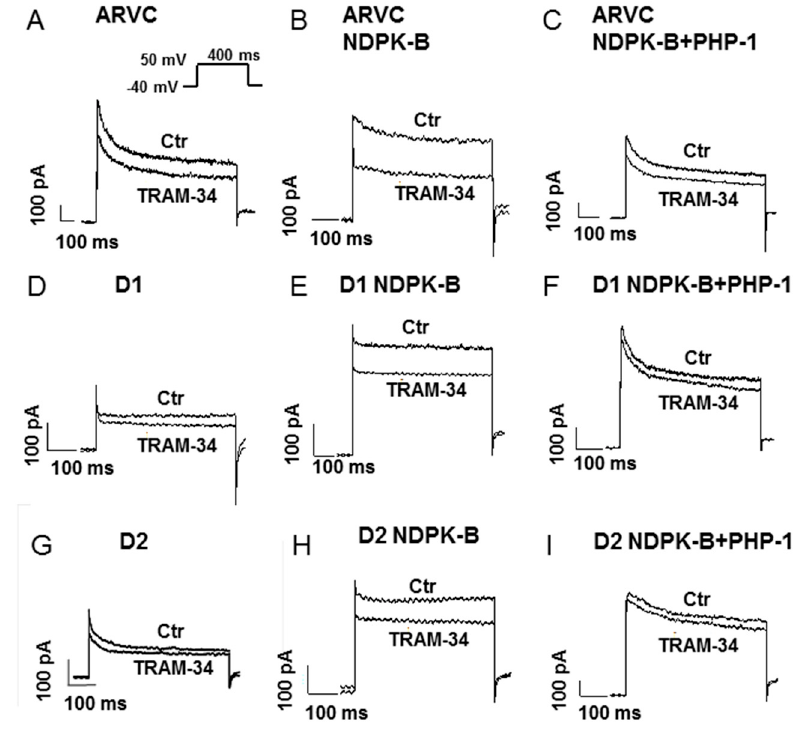
Figure 3. Representative SK4 currents in hiPSC-CMs. SK4 channel currents (I SK4 ) were measured in whole-cell configuration in cells depolarized from − 40 mV to + 50 mV for 400 ms. TRAM-34 (1 µ M) was used to separate I SK4 from other ion channel currents. TRAM-34-sensitive currents represent I SK4 . Recombinant NDPK-B (30 ng / mL), either alone ( B , E , H ) or with PHP-1 (100 ng / ml, C , F , I ), was applied into healthy donor (D1, D2) or ARVC cells though the patch pipette. ( A – C ) Representative currents in ARVC-hiPSC-CMs in the absence (Ctr) and presence of TRAM-34. ( D – F ) Representative currents in D1-hiPSC-CMs in the absence (Ctr) and presence of TRAM-34. ( G – I ) Representative currents in D2-hiPSC-CMs in the absence (Ctr) and presence of TRAM-34.